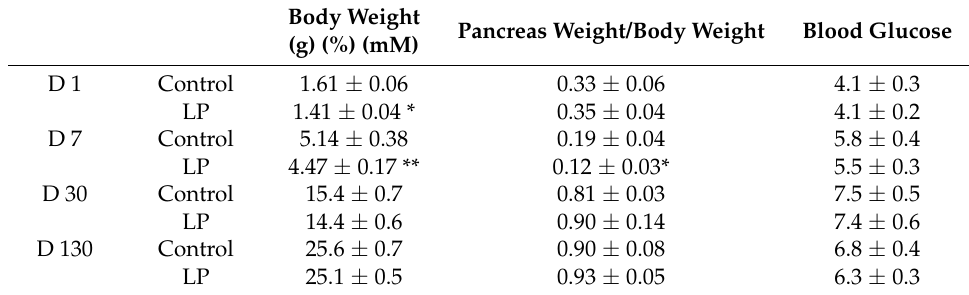
Table 1. Body weight, relative pancreatic weight and blood glucose levels of offspring from control or LP diet-fed mothers from age 1 to 130 days.